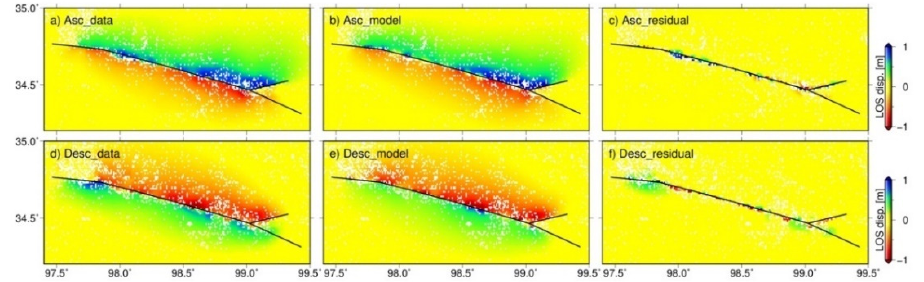
Figure 6. Model fit to the ascending ( a ) observation; ( b ) model prediction; ( c ) residuals and descending ( d ) observation; ( e ) model prediction; ( f ) residuals InSAR coseismic observations. The black lines are up-dip trace of the fault plane used in the fault model.